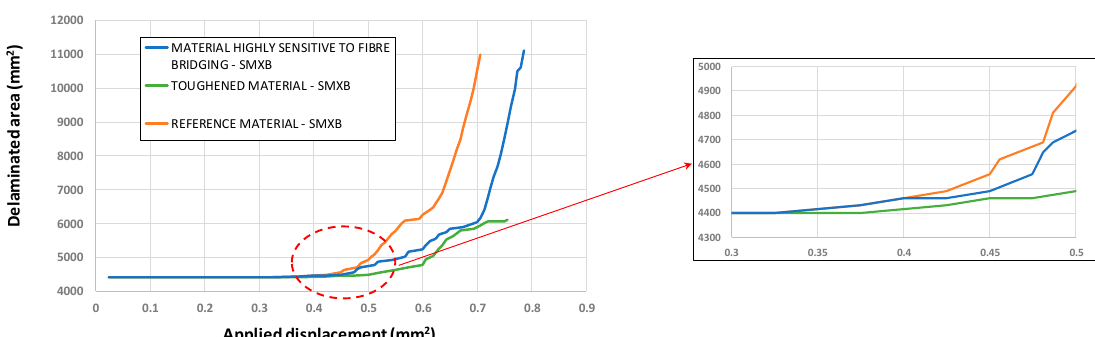
Figure 7. Load vs. Applied displacement (SMXB).